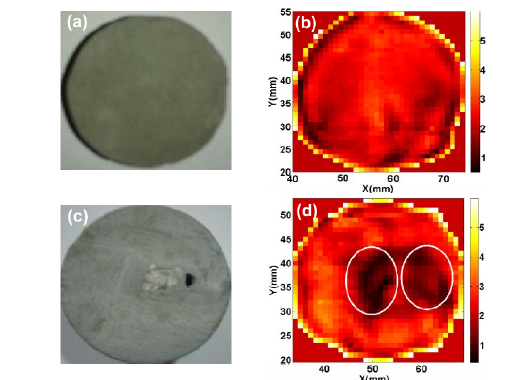
Figure 4. ( a ) Photograph and ( b ) terahertz image of a defect-free concrete sample. ( c ) Photograph and ( d ) terahertz image of a concrete sample with defects. Adapted with permission from 38th International Conference on Infrared, Millimeter, and Terahertz Waves (IRMMW-THz) [39]. Adapted with permission